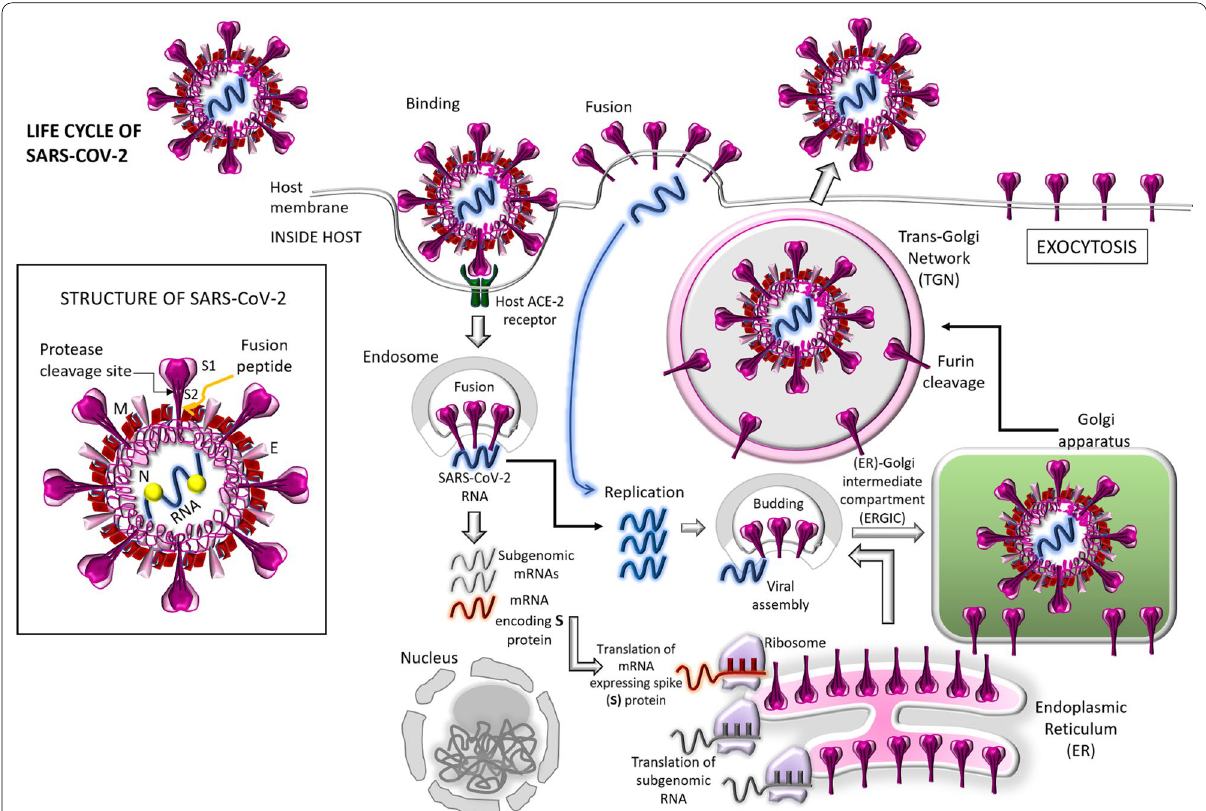
Fig. 1 Life cycle of severe acute respiratory syndrome coronavirus-2 (SARS-CoV-2). In the inset, the structure of SARS-CoV-2 is shown. The release of viral RNA takes place upon the viral entry, followed by the replication of viral RNA leading to the formation of subgenomic RNAs of which one category may encode the viral spike (S) protein (Drosten et al. 2003; Ksiazek et al. 2003; Noor and Maniha 2020). After translation within the ribosomes, the newly synthesized S protein migrates to the lumen of endoplasmic reticulum (ER); and new virus particles generate through budding into the lumen of the ER-Golgi intermediate compartment (ERGIC) (Kahn and McIntosh 2005). With the action of exocytosis, the virions get released; and subsequently the S protein is matured into SI and S2 subunits in the trans-Golgi network (TGN) instigated by the cellular protease, furin (Kahn and McIntosh